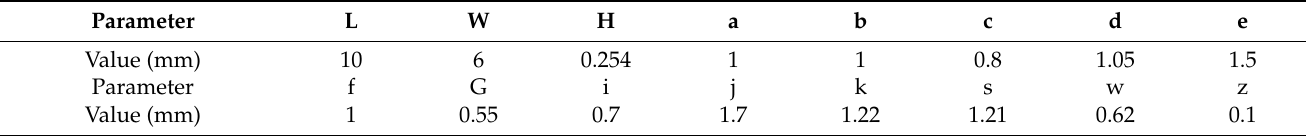
Figure 1. Geometry of the proposed antenna. ( a ) 3D view; ( b ) front view; ( c ) reflection coefficient; and ( d ) element evolution steps. Table 1. Summary of the dimensions of the proposed